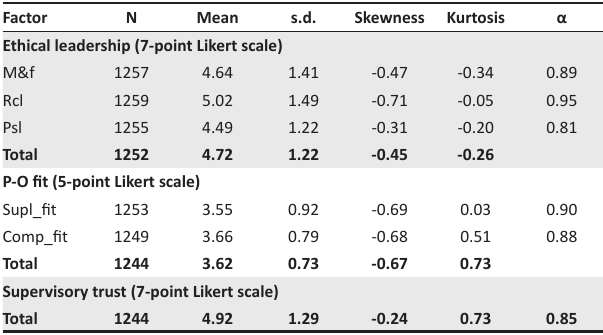
TABLE 1: Descriptive statistics and Cronbach’s alpha coefficients of the factors of the ethical leadership, P-O fit and supervisory trust instruments.